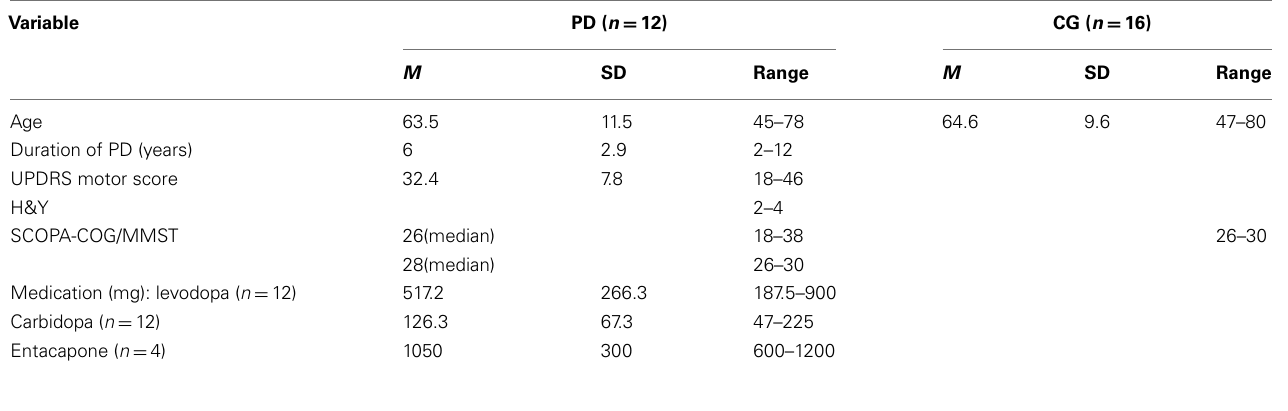
Table 1 | Demographic and clinical characteristics of PD and control